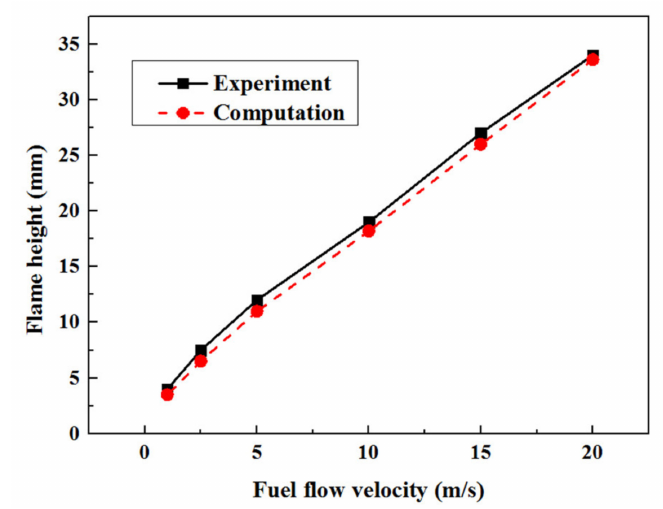
Figure 3. Validation of the numerical results of flame height with experimental data [33].